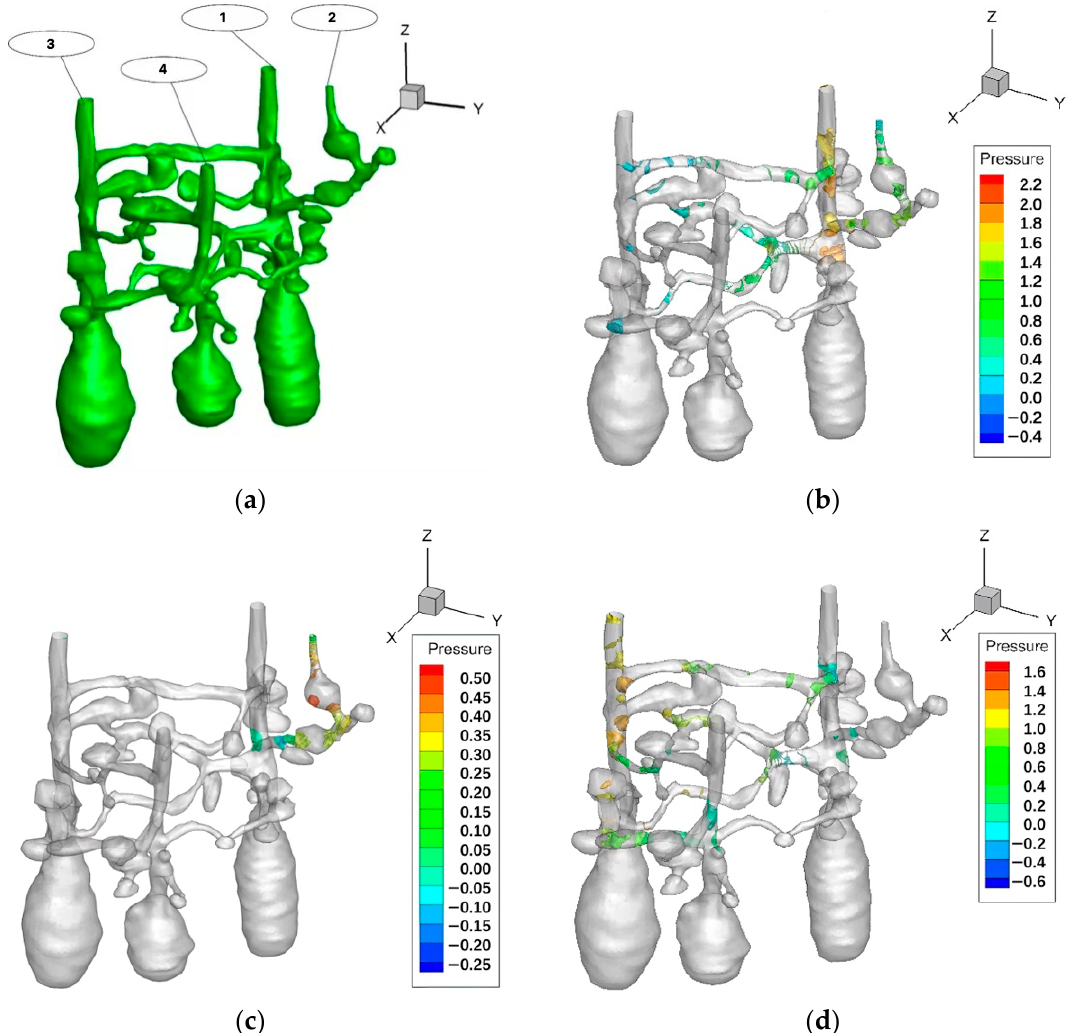
Figure 6. ( a ) 3D model of ant nest structure with inlets 1, 2, 3 and 4; pressure distribution inside the underground ant nest using ( b ) inlet 1, ( c ) inlet 2 and ( d ) inlet 3 as a fluid inlet, respectively.